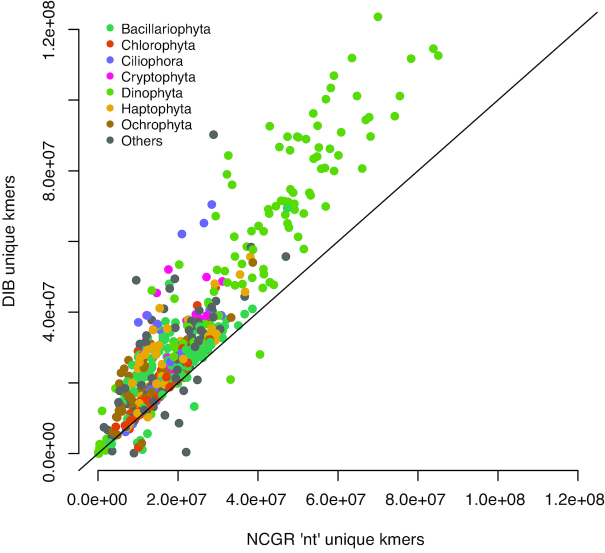
Unique numbers of k-mers (k = 25) in the seven most represented phyla, calculated with the HyperLogLog function in the khmer software package. DIB re-assemblies were compared to the NCGR ‘nt' assemblies along a 1:1 line. Samples are colored based on their phylum level affiliation. More than 95% of the DIB re-assemblies had more unique k-mers than to the NCGR assembly of the same sample.